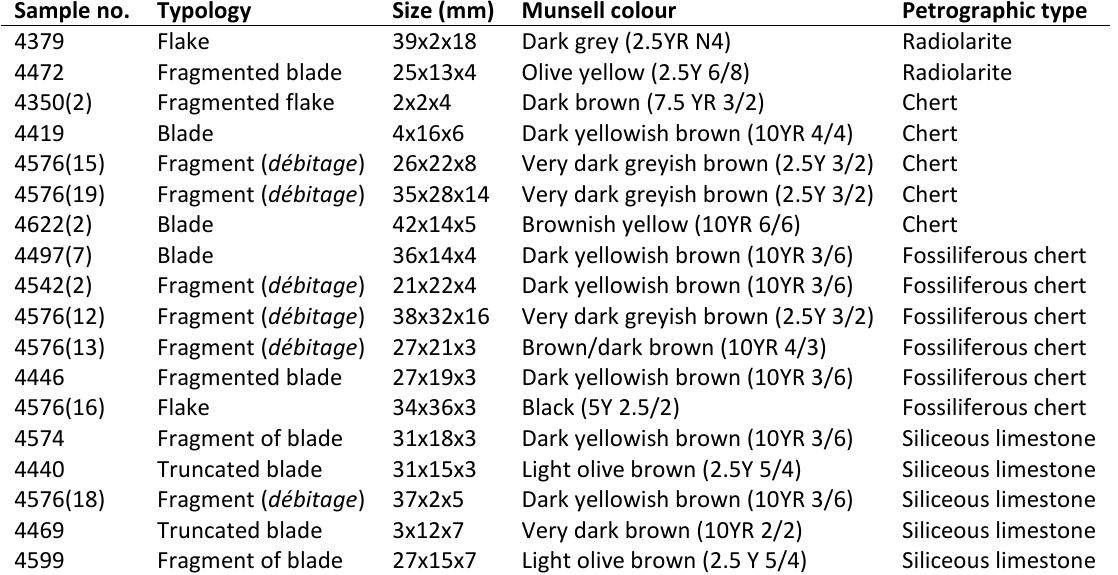
Table 1. Typology, size, colour, and petrographic types of the representative samples. Sample